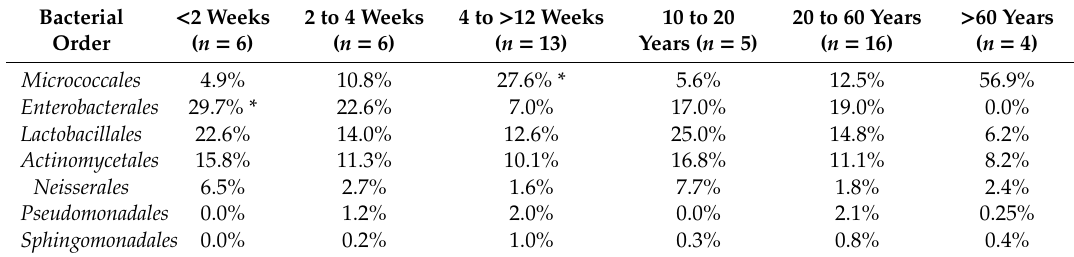
Table 3. Percentage of bacterial orders based on period of use and age of the users. Significantly higher fractions are marked with a * based on non-parametric Mann-Whitney test ( p ≤ 0.05).